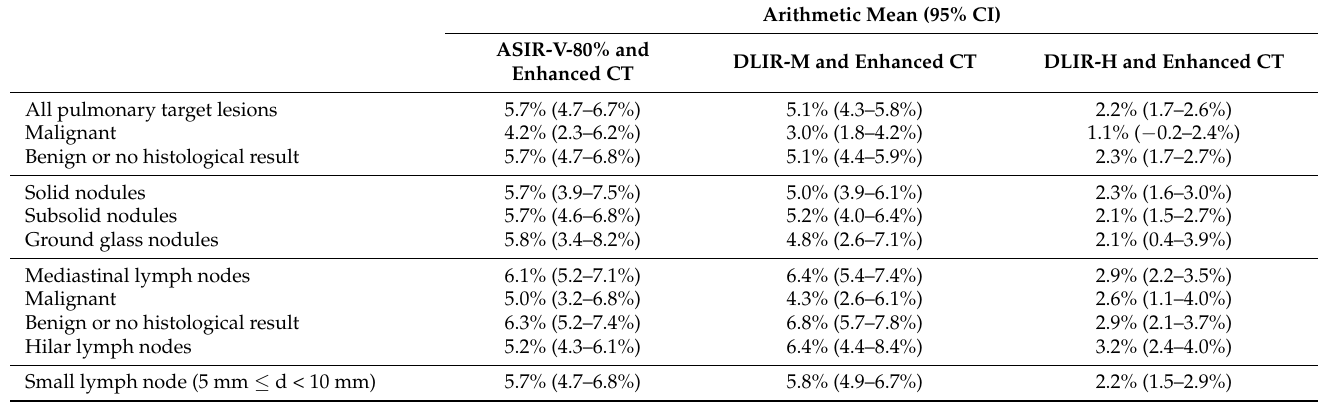
Figure 4. A 64-year-old man had a solid nodule in the middle lobe of the right lung and the histological result was lung adenocarcinoma. ( A ) The long diameter measured on the contrast-enhanced CT is 6.94 mm. ( B ) The long diameter measured on the ASIR-V-80% image is 8.02 mm, overestimated by 15.6% compared with that of contrast-enhanced CT. ( C ) The long diameter measured on the DLIR-M image is 8.21mm, overestimated by 18.3%. ( D ) The long diameter measured on the DLIR-H images is 7.62 mm, overestimated by 9.8%. Table 5. Bland-Altman analysis of measured diameters of RECIST-defined nonmeasurable lesions between ultra-low-dose CT and contrast-enhanced